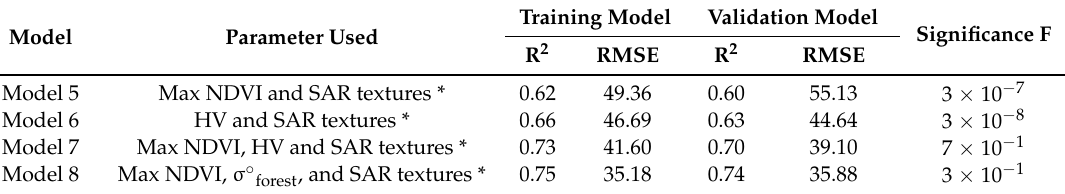
Table 7. The training and validation results using coefficient of determination (R 2 ) and root mean square error